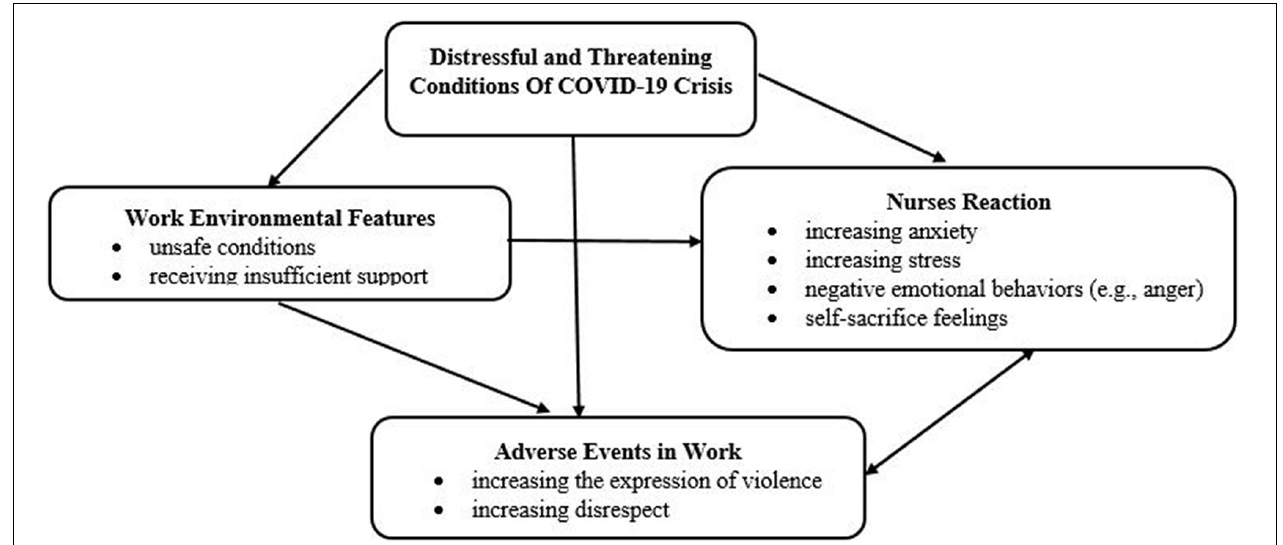
FIGURE 1 | Process of the influential event on intensifying workplace violence in the COVID-19 crisis.